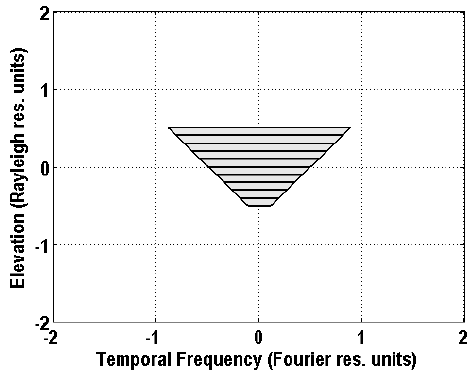
Figure 1. Sketch of spatio-temporal spectrum support and ridge components, decorrelating volume scatterer, − 3 dB temporal bandwidth.